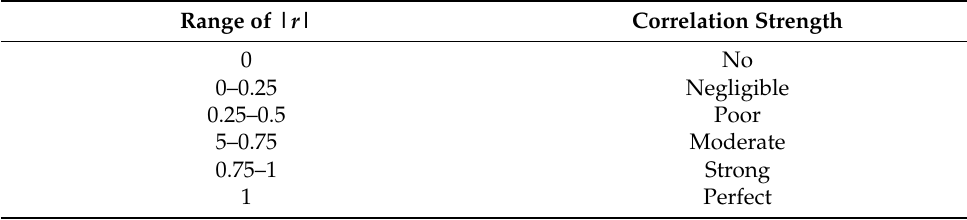
Table 1. Pearson’s correlation coefficients (PCCs) related to the correlation strength.